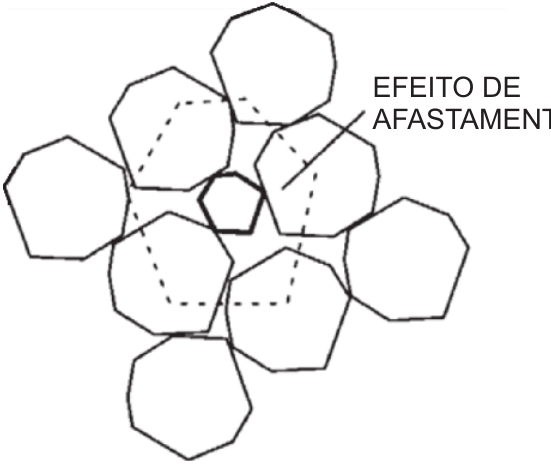
Figura 3 Efeito de afastamento (adaptado de [16])